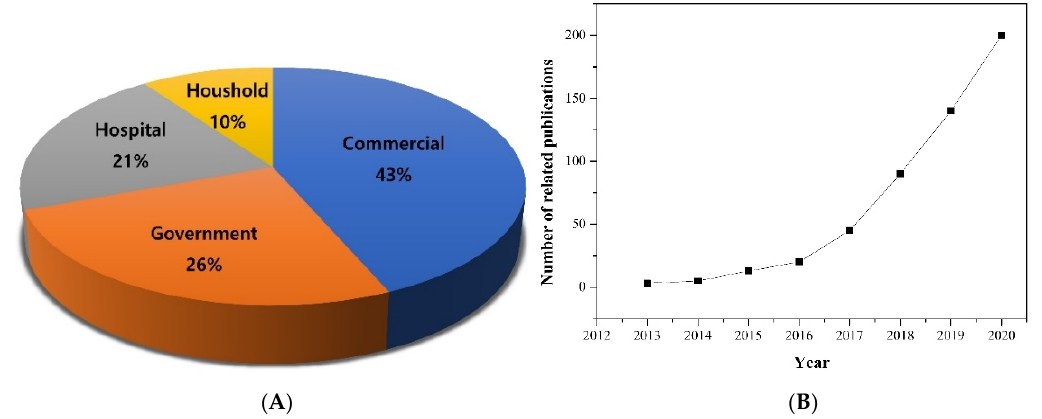
Figure 4. Statistical data of ( A ) The global market size for each type of 3D food printing service. 3D Bioprinting market size, share & trends analysis report by technology market analysis report, available online: https://www.grandviewresearch.com/industry-analysis/3d-bioprinting-market (accessed on 12 August 2021). ( B ) Research articles on the topic of 3D bioprinting technology pub- lished during 2013–2020. Table 5 represents the global 3D food printing market. In detail, the market share in 2018 was 39% for confectionery, 22.4% for dough, 16.5% for dairy products, 10.5% for fruits and vegetables, 7.1% for meat, 4.4% for other (source, supplement, and snack), and 61.4% for confectionery and dough. The reason for this ratio is that confectionery and dough are easier to print in various shapes than other products. The average annual growth rate of each product from 17 to 23 was high in the order of meat (49.5%),